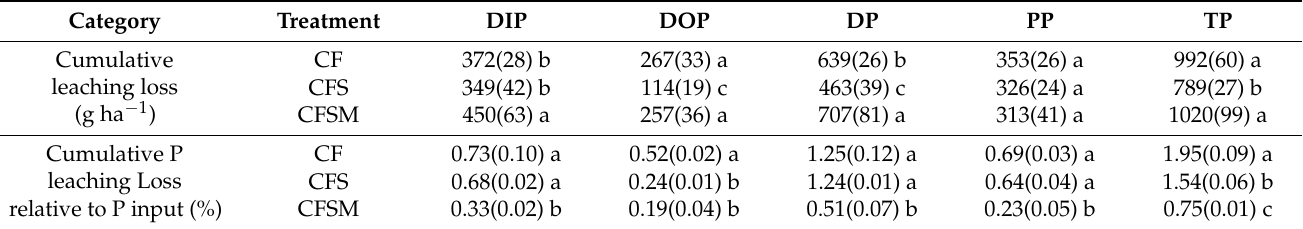
Table 4. Cumulative leaching loss of each P form and its ratio to P input in